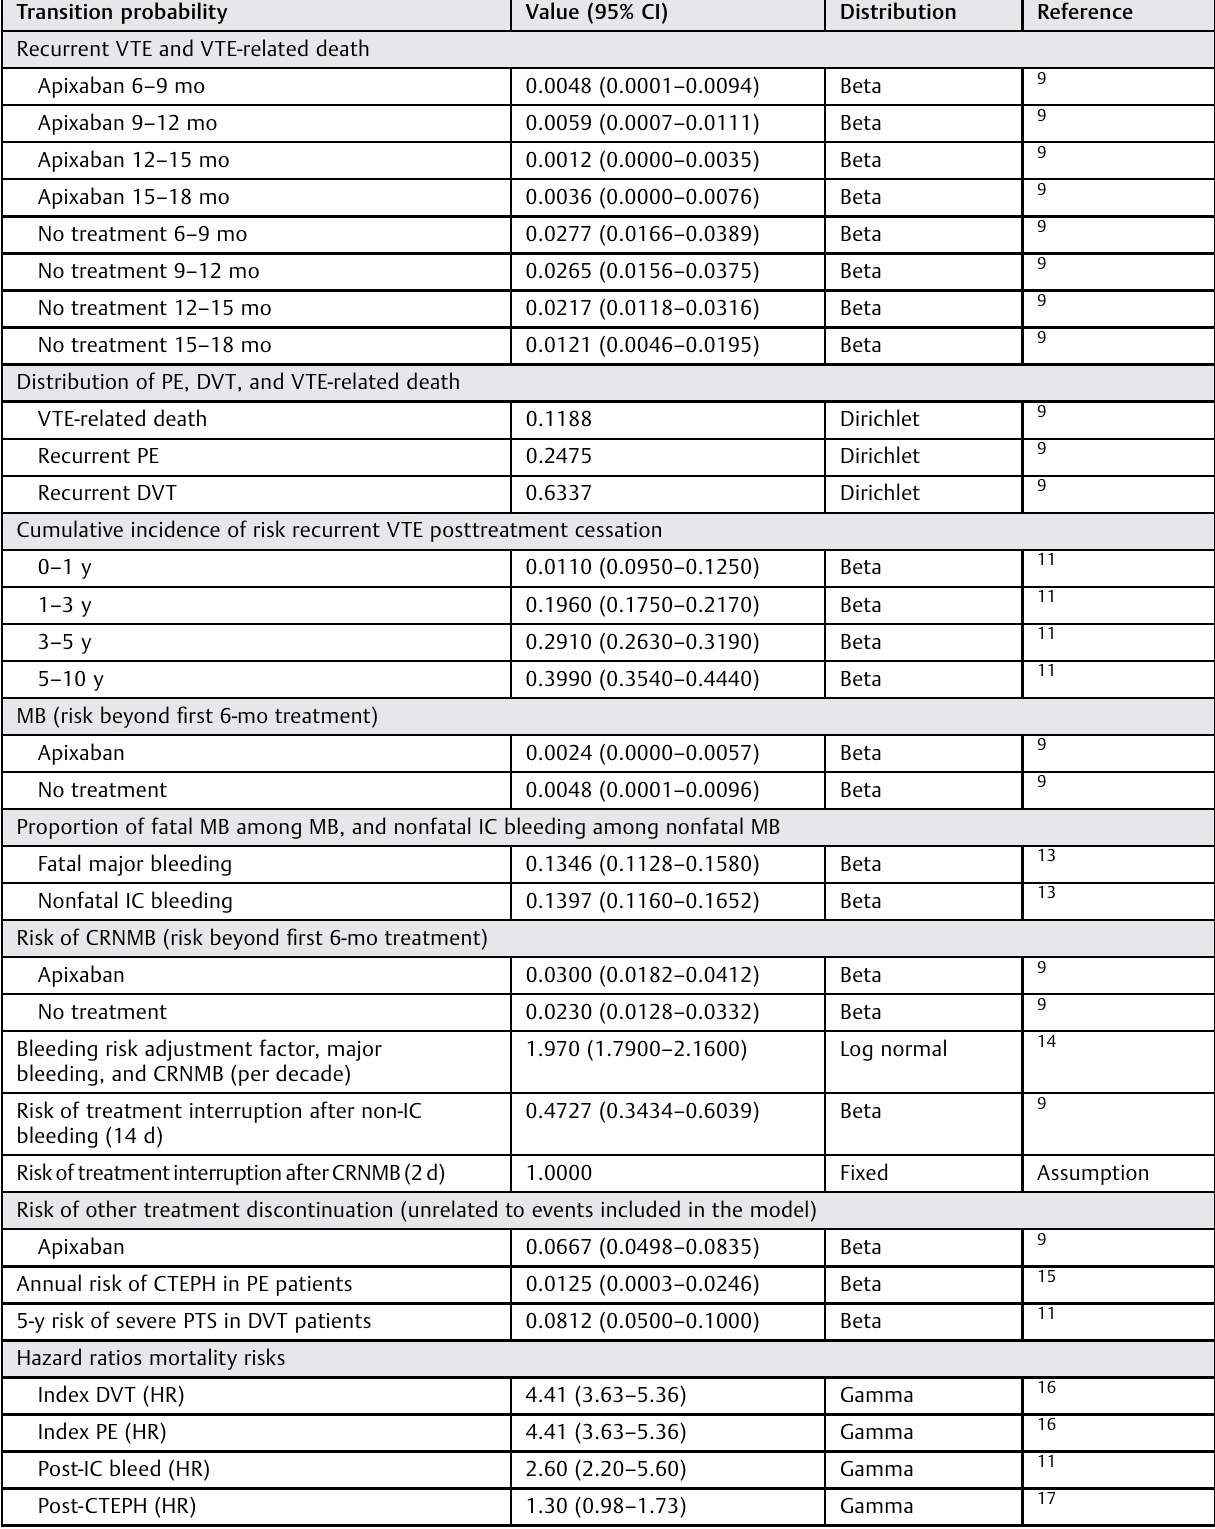
Table 1 Base-case transition probabilities used in the Markov model for the extended treatment